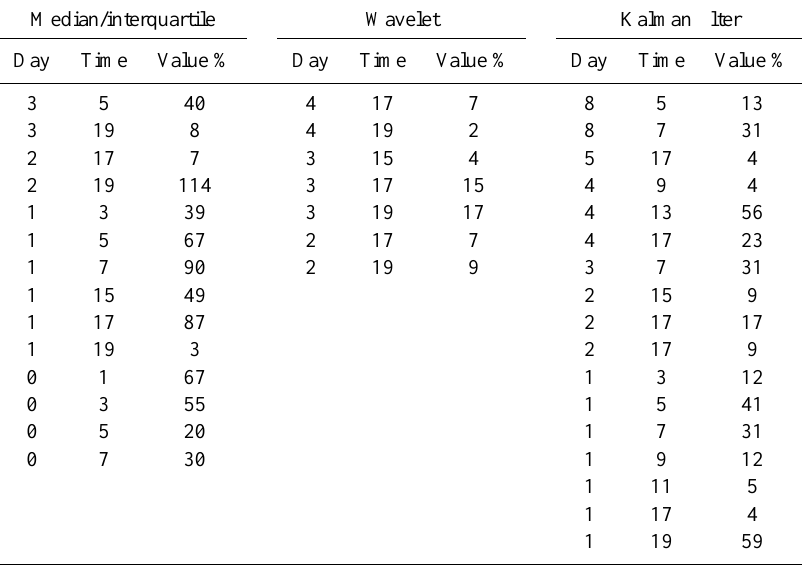
Table 2. Detected anomalies for the Haiti earthquake (12 January 2010) using the median/interquartile, wavelet and Kalman filter methods. Day is relative to the earthquake day. Value calculated by p = ± 100 × ( | Dx |− k) /k (Akhoondzadeh and Saradjian, 2011).